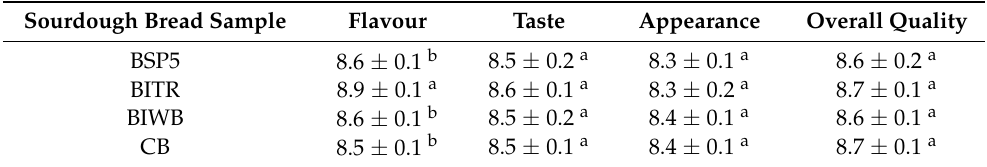
Table 3. Sensory evaluation test (consumer preference) of breads made with sourdoughs prepared with freeze-dried L. paracasei SP5 and with the control